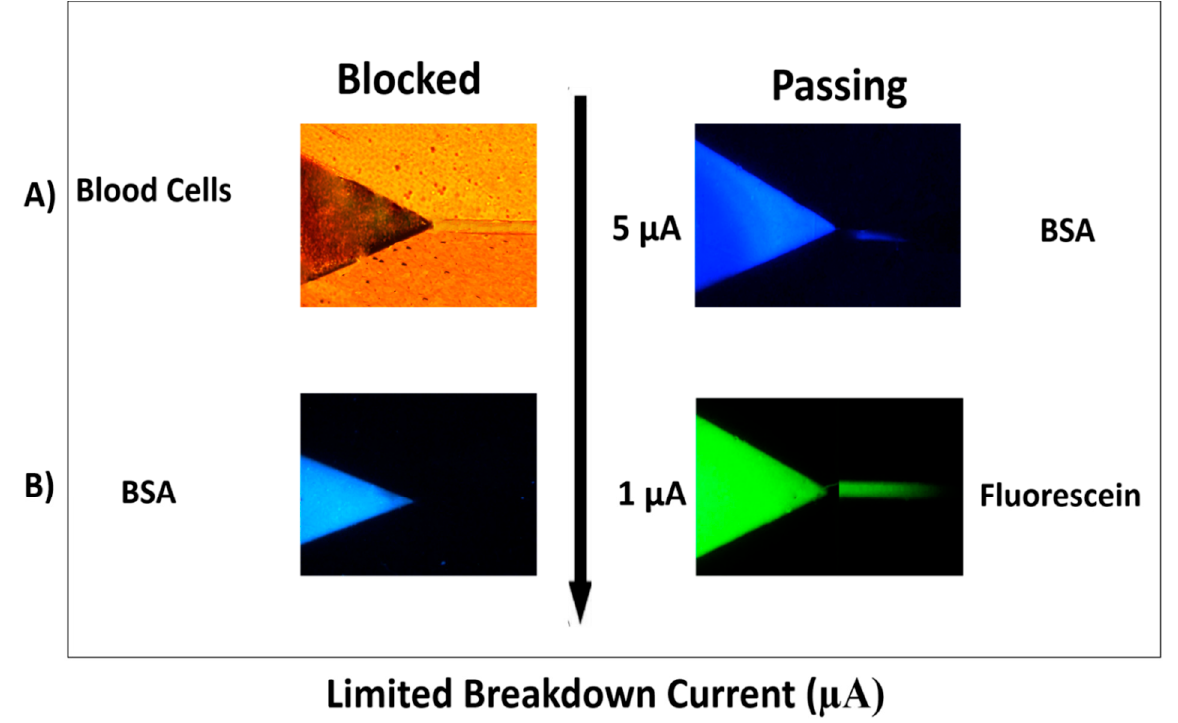
Figure 3. Screenshots presenting the restriction (left column) and passing (right column) of different molecules through nano-junctions formed under different conditions. ( A ) shows the use of 5 µ A to create nanochannels which transported Bovine Serum Albumin (BSA) (blue, right) and restricted Blood Cells (left); ( B ) shows the use of 5 µ A to create nanochannels which restricted BSA (blue, left) and transported fluorescein (green, right). The nanochannels formed using a breakdown electrolyte of 10 mM phosphate buffer, pH = 11, and terminating currents of 5 and 1 µ A. Images on the left show blocked transport, while those on the right show the permeability of different molecules. Scale Bar = 200 µ m.